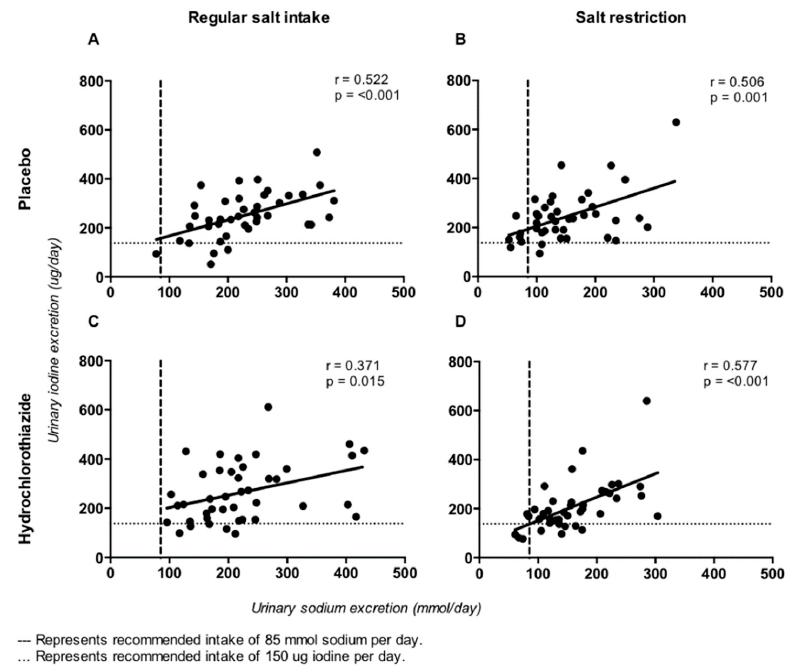
Figure 3. Correlation of 24-h sodium excretion and 24-h iodine excretion during the four different intake with hydrochlorothiazide. D : salt restriction with hydrochlorothiazide.